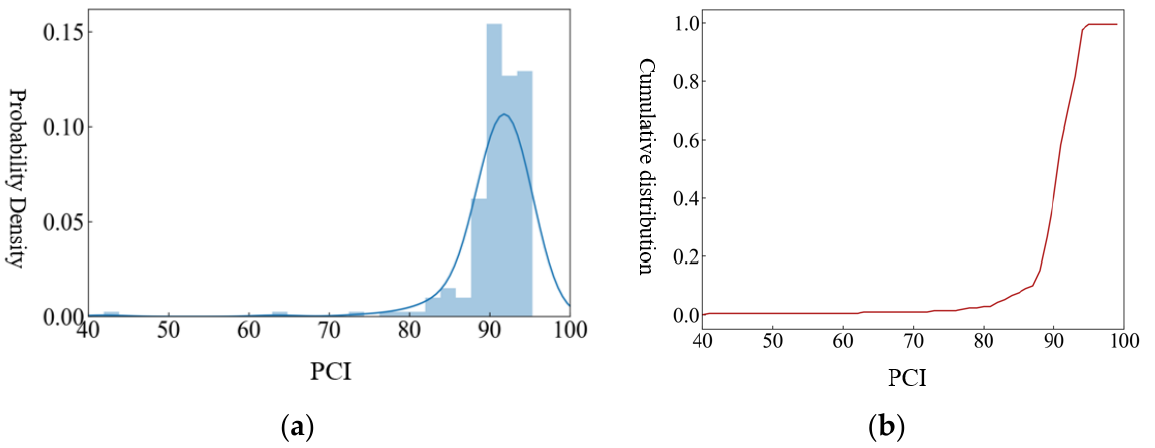
Figure 1. Overall evaluation of the road network after weighting: ( a ) Frequency plot; ( b ) Cumulative distribution plot.